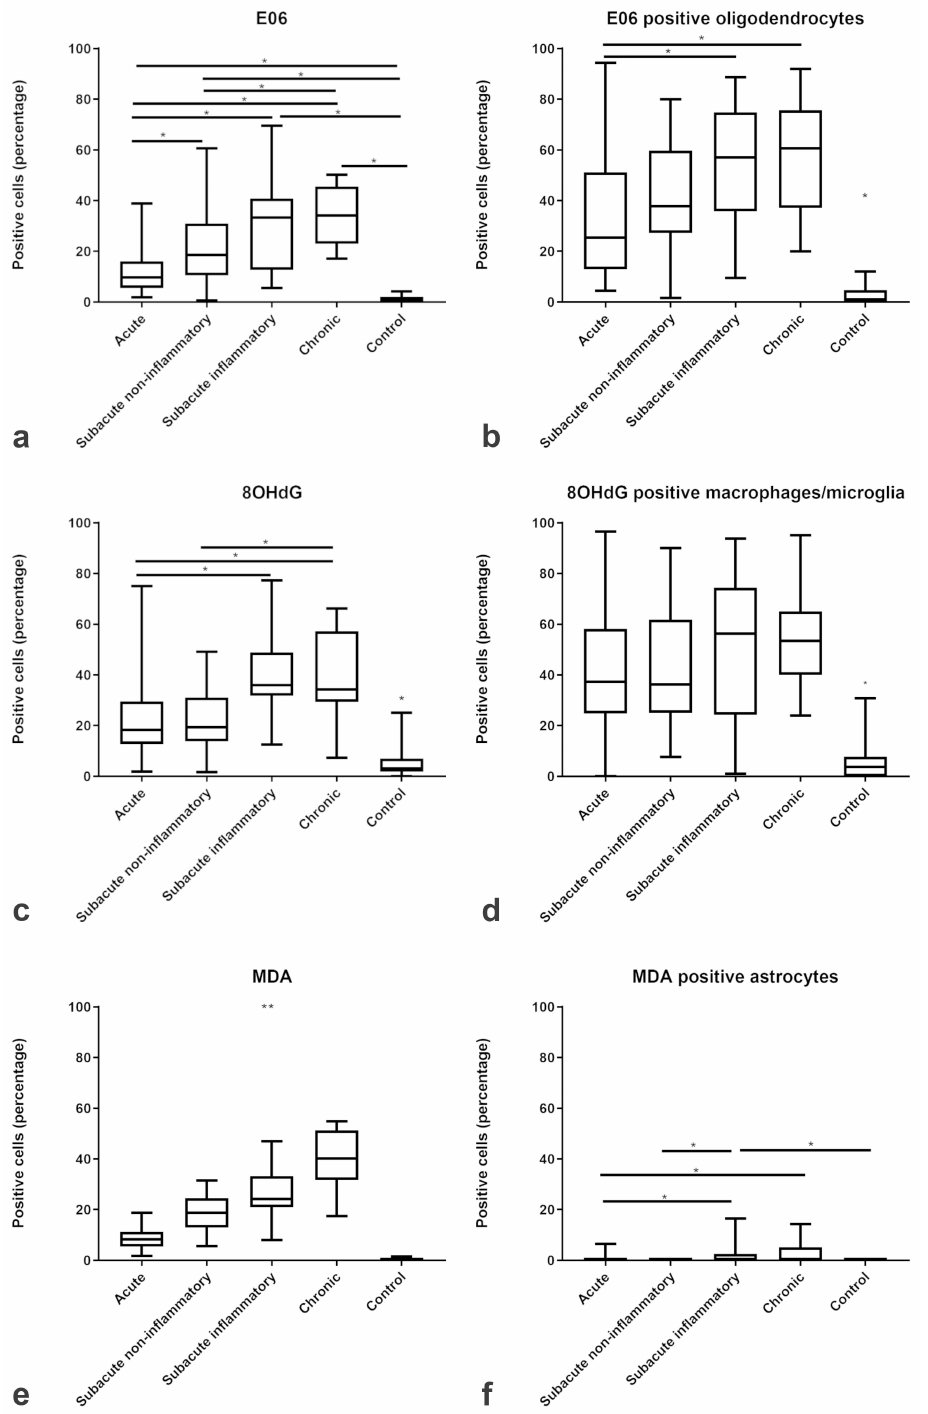
Figure 3. Relative changes in the proportions of cells immunopositive for ROS-products. The box plots show increasing percentages of positive cells for ( a ) oxidized phospholipids (clone E06), ( c ) 8-OHdG / 8-OHG, and ( e ) MDA and the percentage of positive ( b ) oligodendrocytes, ( d ) macrophages / microglia and ( f ) astrocytes positive for ROS products in acute, subacute non-inflammatory, subacute inflammatory, and chronic CDV-DL lesions as compared to controls. Significant di ff erences between the groups as revealed by the Kruskal–Wallis test with independent pairwise post-hoc Mann–Whitney U-test are marked with an asterisk (* p ≤ 0.05, ** p ≤